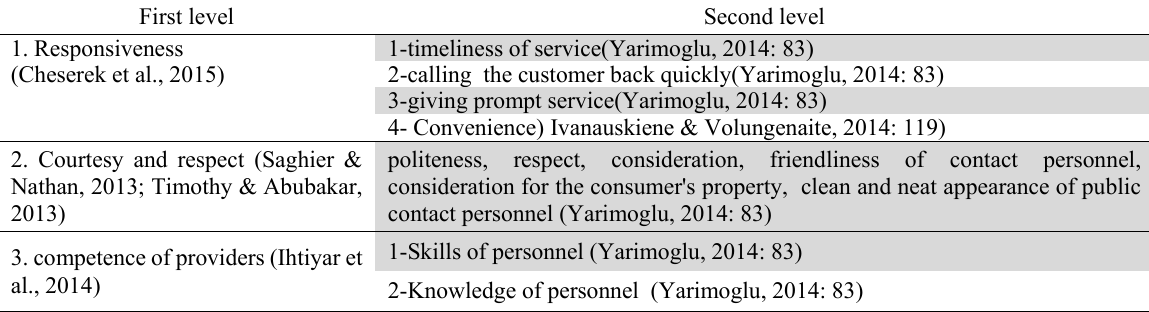
Factors related to personnel behaviors at abstract and concrete levels First level